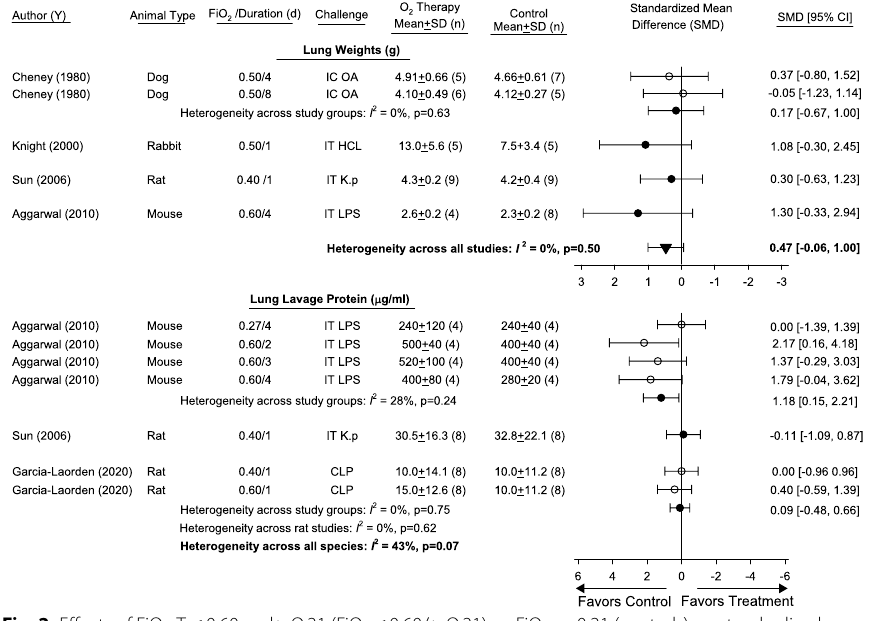
Fig. 2 Effects of FiO 2 sT mean differences